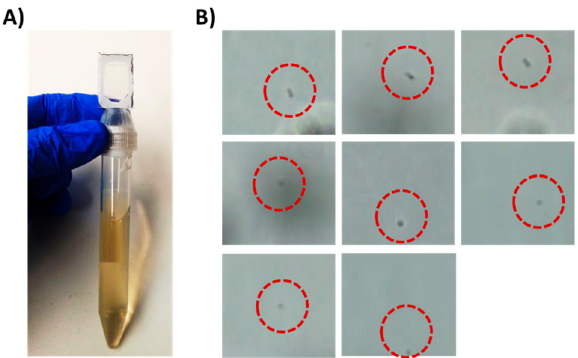
Figure 2. Detection of 5 × 10 3 E. coli cells/mL in a liquid sample as a model for UTI diagnostics. ( A ) A 15 mL tube with Chip #1 attached to it. The tube holds 10 mL sample spiked with E. coli cells. ( B ) Trapped bacterial cells as observed under a brightfield microscope equipped with 60× objective after centrifugation.